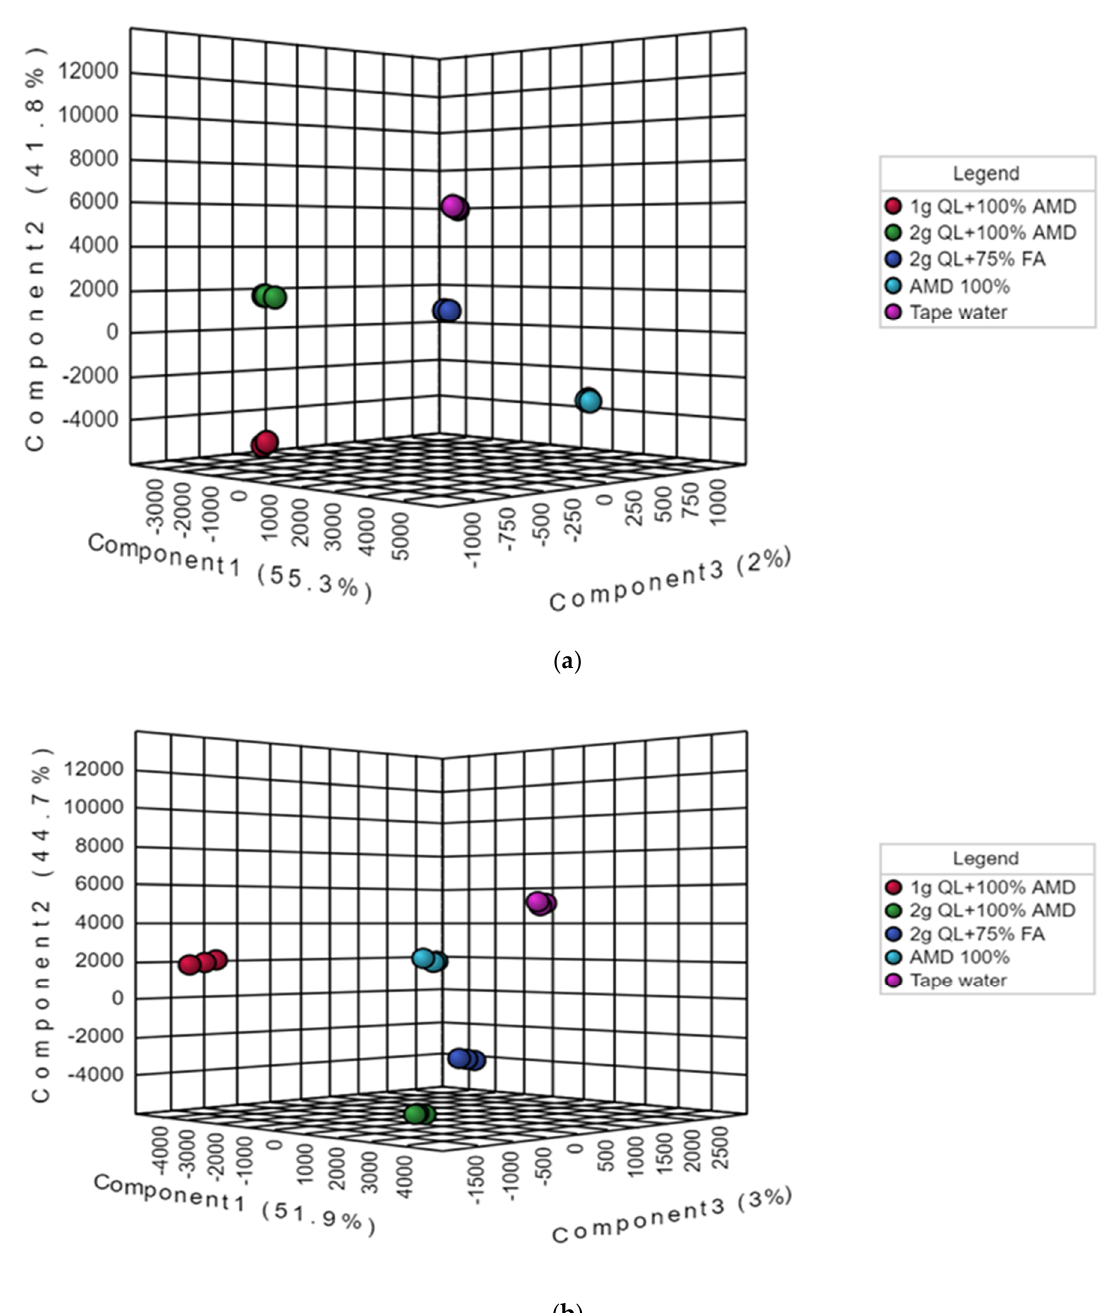
Figure 2. Partial least squares-discriminate analysis (PLS-DA) score plots of metabolic profiles from liquid chromatography linked to mass spectrometry data of samples from Marykies ( a ) and Royal ( b ) potato tuber samples. Different colors denote different treatments: tap water (T1): purple, AMD 100% (T2): light blue, 1 g QL + 100% (T3): red, 2 g QL + 100% AMD (T4): green and 2 g QL + 75% FA (T5): dark blue, respectively.